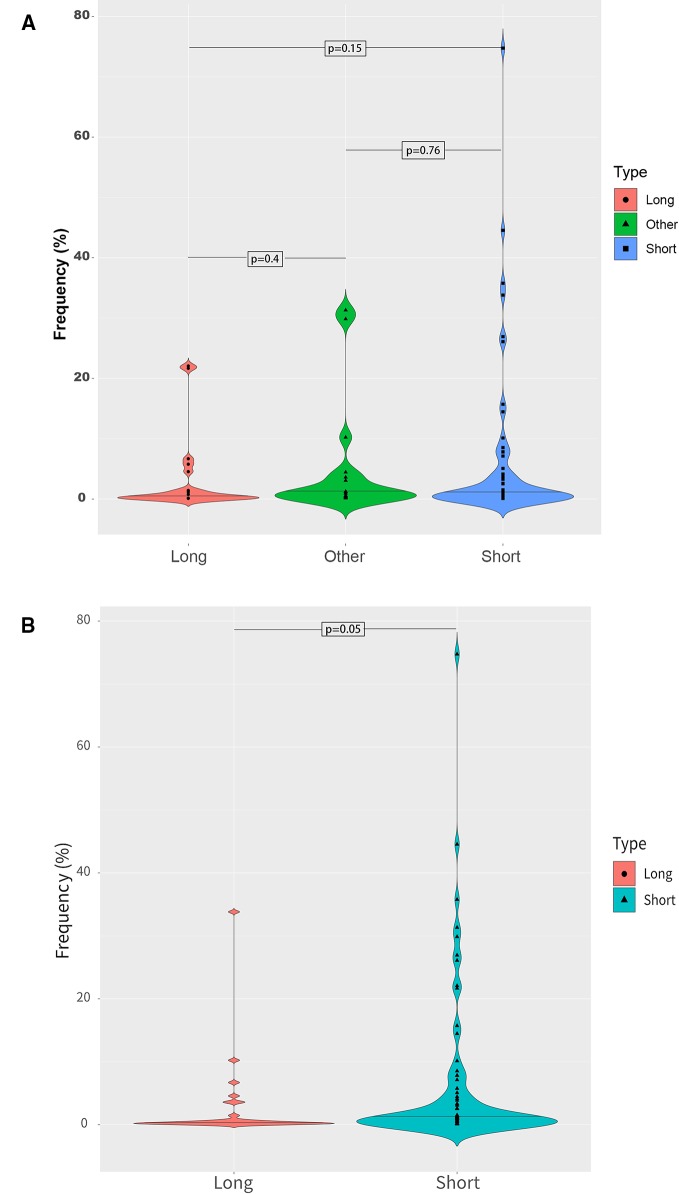
Mutant allele frequency distributions based on ctDNA fragment length. (A) Relationship between the mutation fragment size peak and the mutation frequency. (B) Relationship between the median mutation fragment size peak and the mutation frequency.